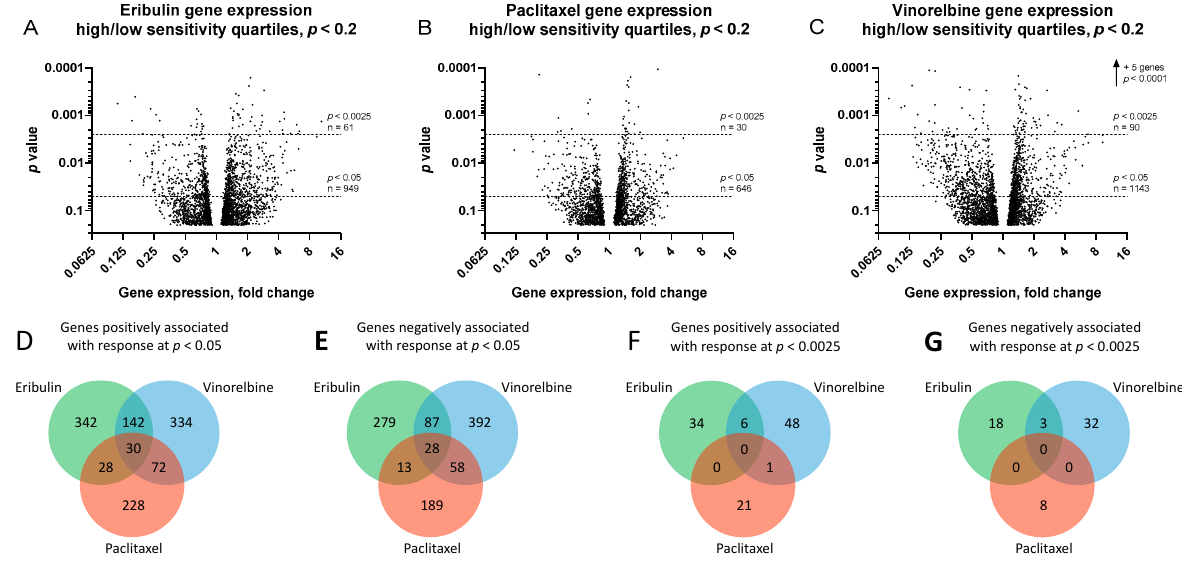
Figure 3. Genes associated with responses to eribulin, paclitaxel and vinorelbine. Volcano plots of ratios of gene expression levels between most and least sensitive cell line quartiles are plotted versus p -values for eribulin ( A ), paclitaxel ( B ) and vinorelbine ( C ). For visual clarity, only genes with p < 0.2 are plotted (3149, 2486 and 3435 genes for eribulin, paclitaxel and vinorelbine, respectively). Horizontal dashed lines denote statistical significance and numbers of genes below p < 0.05 and p < 0.0025. Venn diagrams of numbers of genes positively ( D , F ) and negatively ( E , G ) associated with responses to eribulin, paclitaxel and vinorelbine at p < 0.05 ( D , E ) and p < 0.0025 ( F , G ) stringency levels are